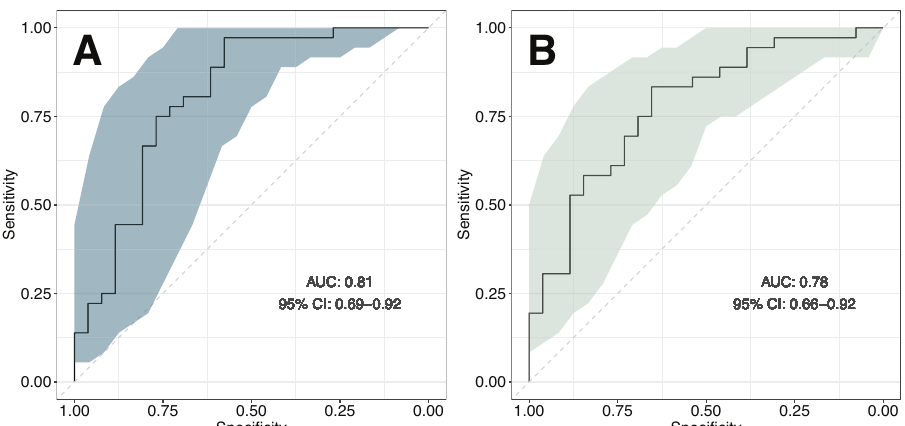
Fig. 2 Performance of the biomarker-based multivariable diagnostic model in separating recent-onset schizophrenia patients ( n = 36) from healthy controls ( n = 26) in the original cohort. Shown are receiver operating characteristic (ROC) curves of the three-biomarker model ( A ) and two-biomarker model ( B ), with sensitivity con fi dence intervals (CI) marked in teal and light green, respectively. The area under the ROC curve (AUC) was calculated using leave-one-out